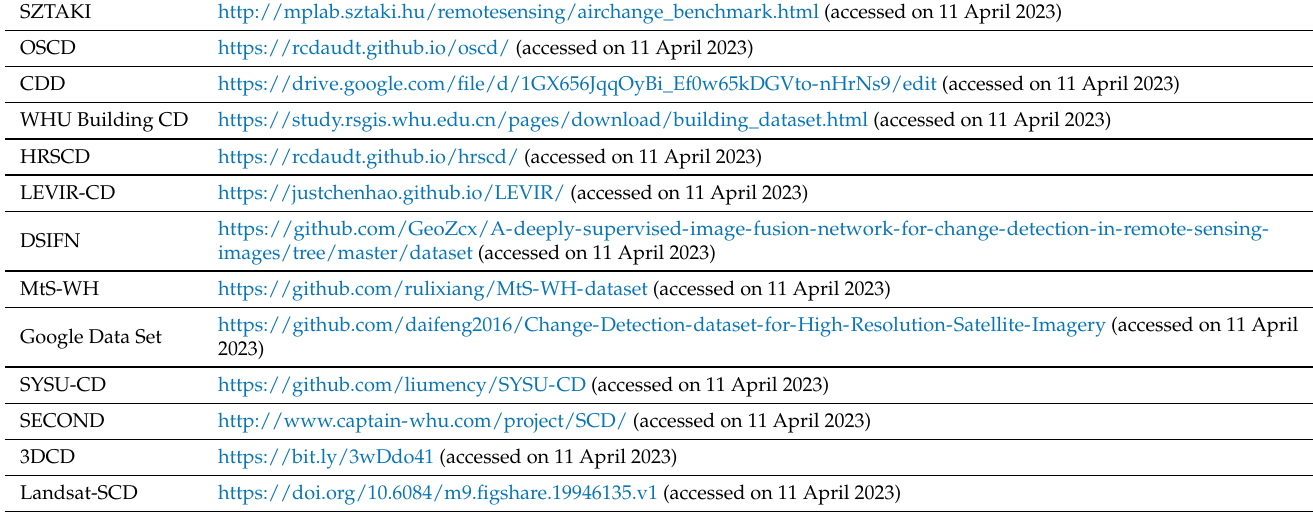
Table A1. Links to the reviewed